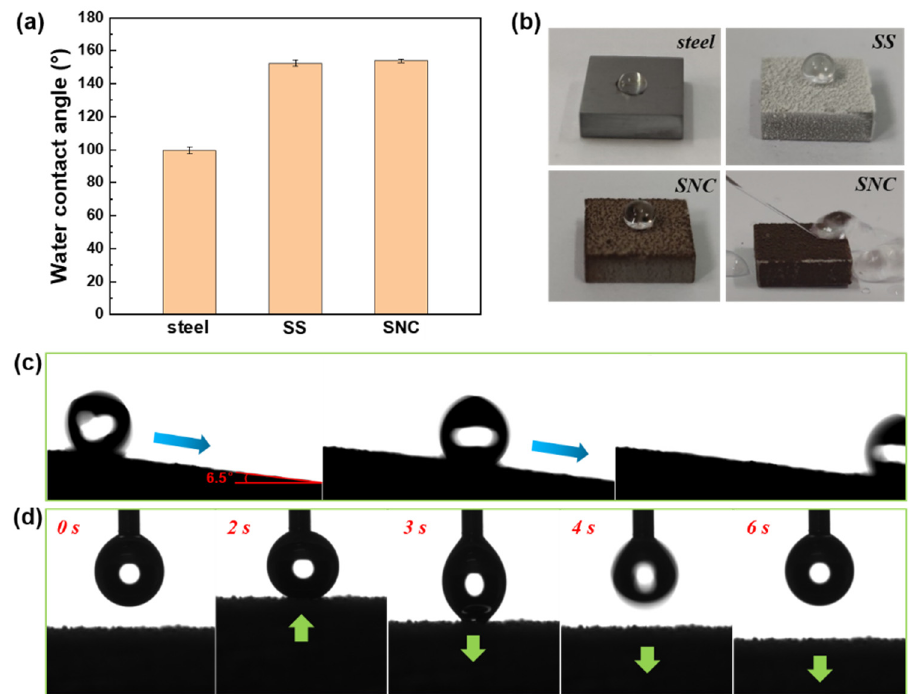
Figure 6. ( a ) Water contact angle of steel surface, SS, and SNC; ( b ) photographs of a water droplet on steel surface, SS, and SNC and the video snapshot of the rolling state of water on SNC; ( c ) video snapshots of the rolling behavior of the water droplet on SNC; ( d ) video snapshots of the low adhesion behavior of the water droplet on